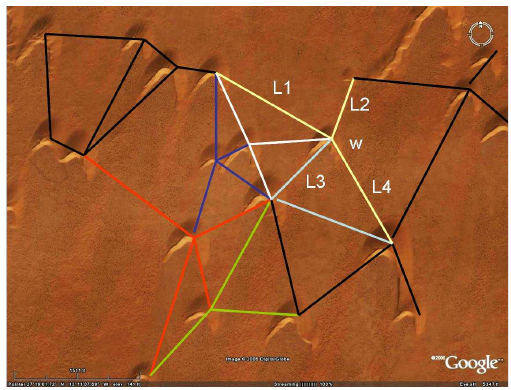
Fig. 2. (Color online) Dune field planar network. The neighbor- hood of a dune of width w is defined by its nearest neighbors in each of the four quadrants placed at a distance L 1 , L 2 , L 3 and L 4 ,